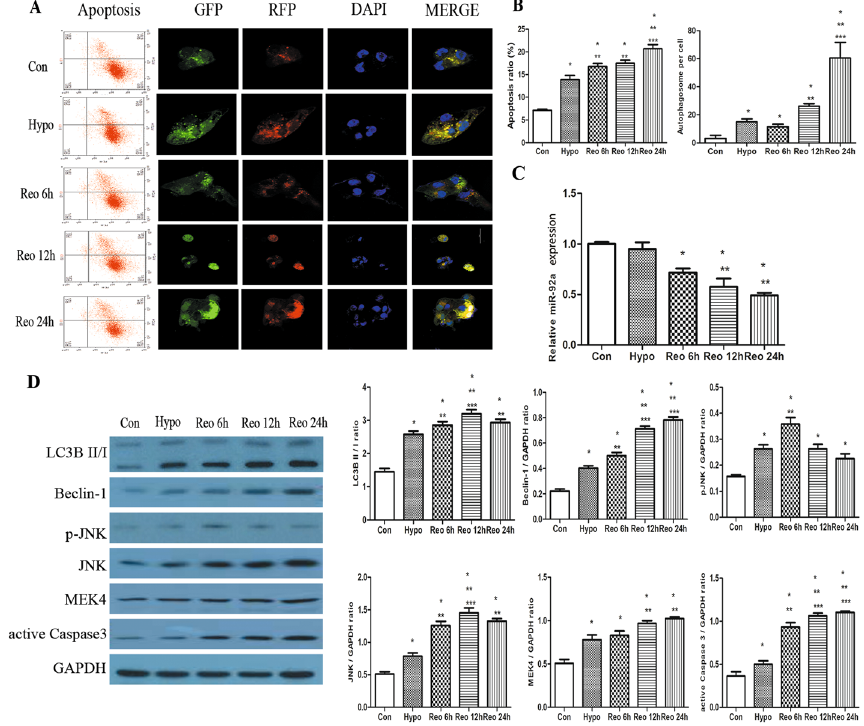
Fig. 2 Hypoxia and reoxygenation increased apoptosis and autophagy of HK-2 cells. Representative images A and statistical results B of HK-2 cells apoptosis and autophagy among different groups (original magnification 200). C The expression of miR-92a. Using Western blotting, representative band and statistical × analysis D of LC3B II/I, Beclin 1, pJNK, JNK, MEK4, and active caspase 3 expression. * P < 0.05. Con control,